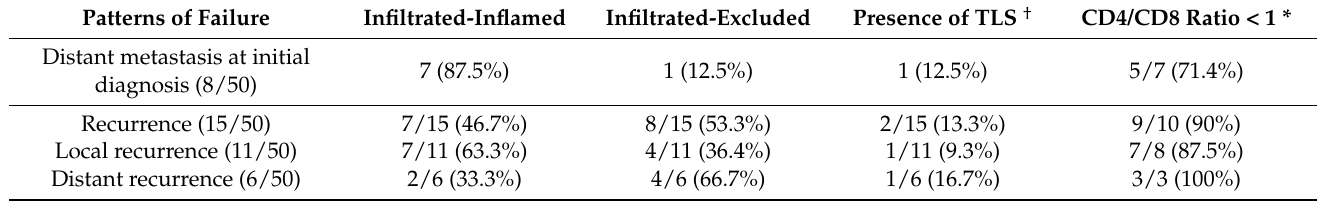
Table 2. TIL patterns and presence/development of distant metastases and